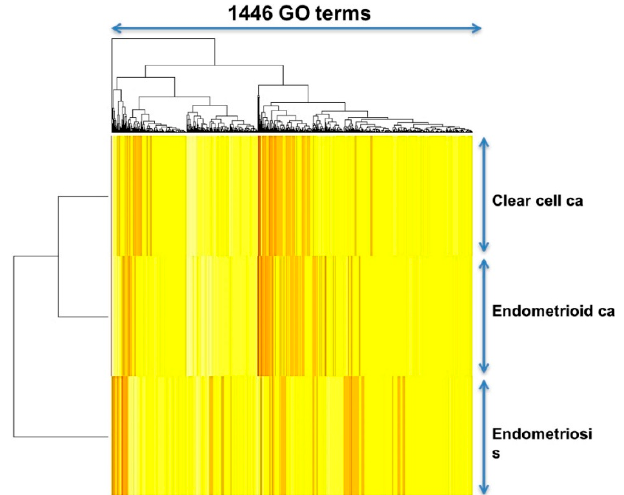
Figure 2. Histograms of the gene set regularity indices for the three diseases and control groups. The figures show the distributions of gene set regularity (GSR) indices from the three diseases (orange) and control groups (blue). The control group for CCC and EC is identical.